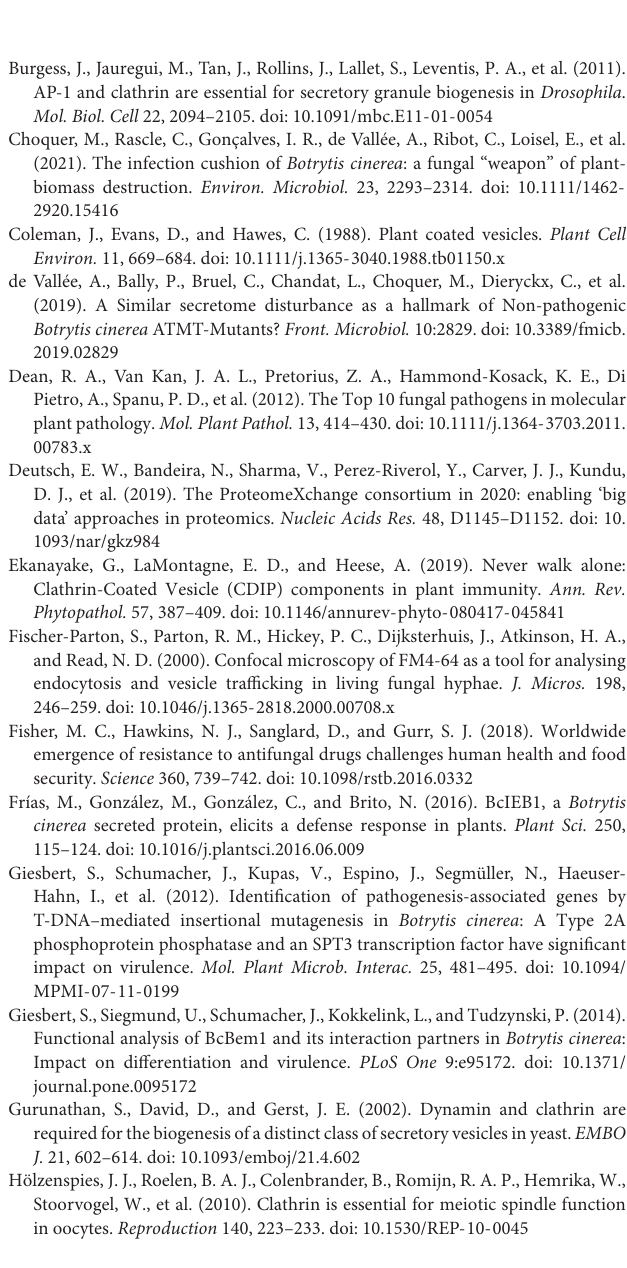
( Supplementary Table 1 ). (C) Southern blot analysis. Genomic DNA was digested with Nco I and probed with a digoxigenin-labeled DNA fragment corresponding to the hph gene (black box in A). T2.16 strain shows single T-DNA insertion. Black arrows indicate the sizes of the T2.16 hybridized fragments (2.56 and 14.9 Kb). ( ∗ ) ATMT-transformants strains not retained in this study. LB, left border; RB, right border. Supplementary Figure 2 | Characterization of HUB mutants. (A) Radial growth of the parental and mutant (T2.16 and 4 HUB) strains after 4 days on sporulation medium. Means of three independent experiments are shown with standard deviations and statistic significant differences compared to the parental strain (Student t -test; ∗∗∗ p -value < 0.001). (B) Pathogenicity assays. The virulence of four HUB mutants was compared to that of the parental (B05.10) and T2.16 mutant strains on primary leaves of French bean and cucumber cotyledons. Agar